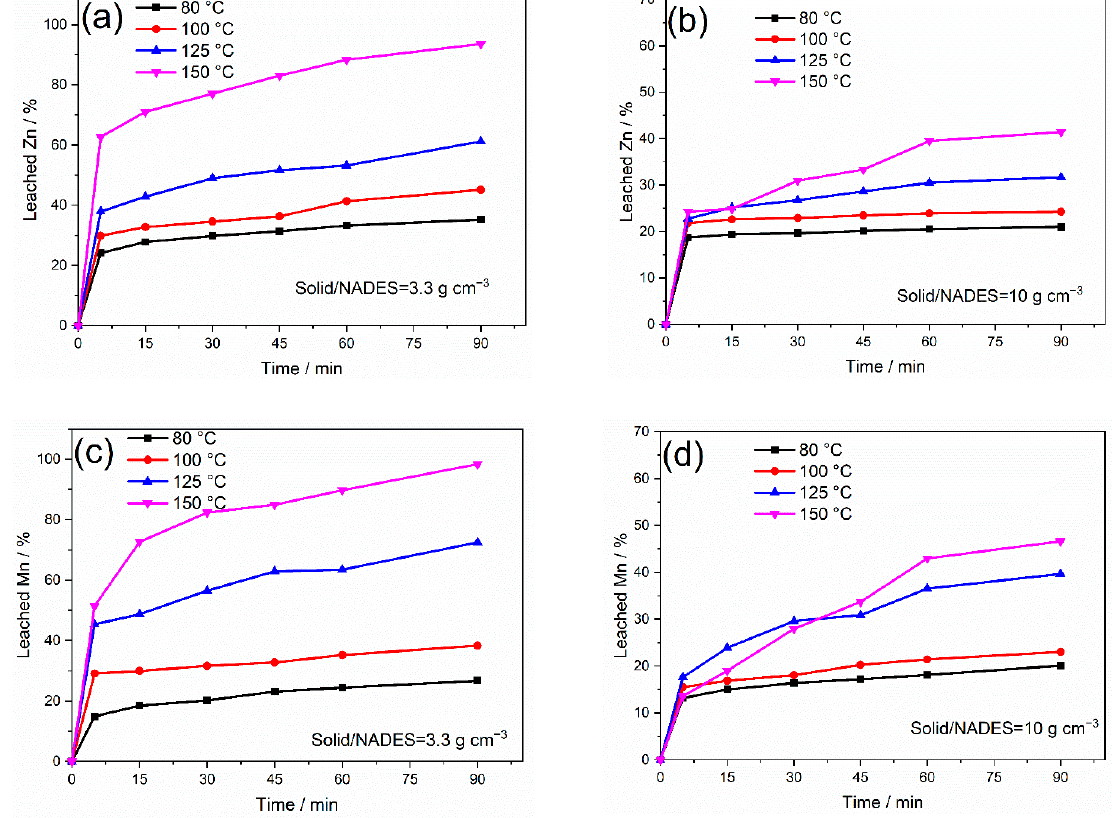
Figure 2. Zn and Mn oxide leaching for both solid/NADES ratios, as a function of temperature: ( a ) Zn oxides, 3.3 g dm − 3 ; ( b ) Zn oxides, 10 g dm − 3 ; ( c ) Mn oxides, 3.3 g dm − 3 ; and ( d ) Mn oxides, 10 g dm − 3 .